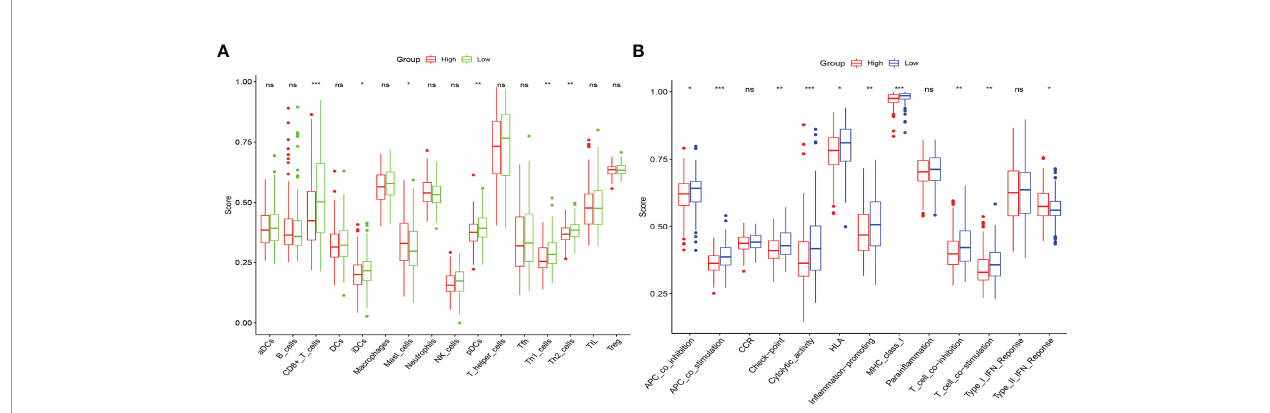
FIGURE 6 | The scores of 16 immune cells (A) and 13 immune-related functions (B) are displayed in boxplots. *, P < 0.05; **, P < 0.01; ***, P < 0.001; ns, P >